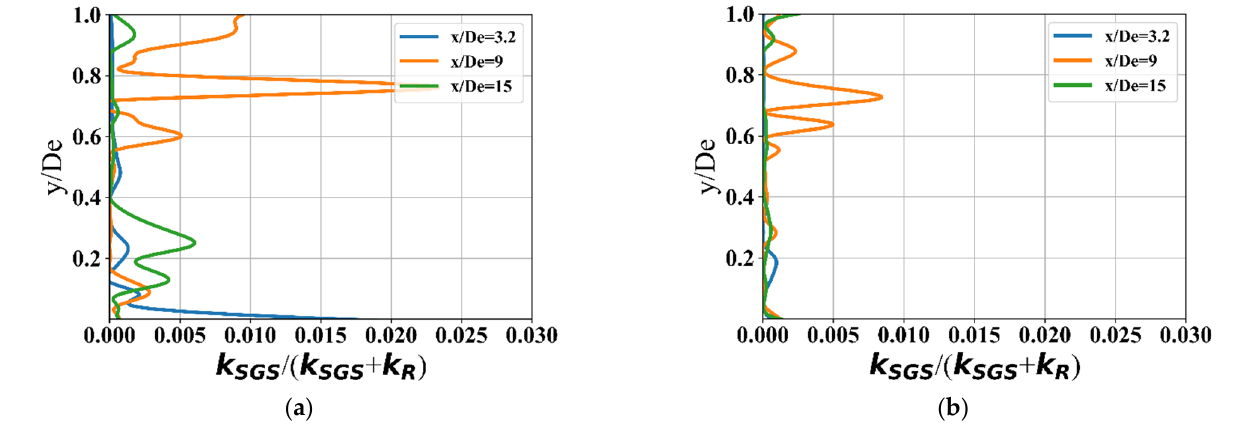
Figure 2. Ratio of subgrid-scale to total TKE at various streamwise locations. ( a ) LEScold —minor axis plane, ( b ) LEShot —minor axis plane.